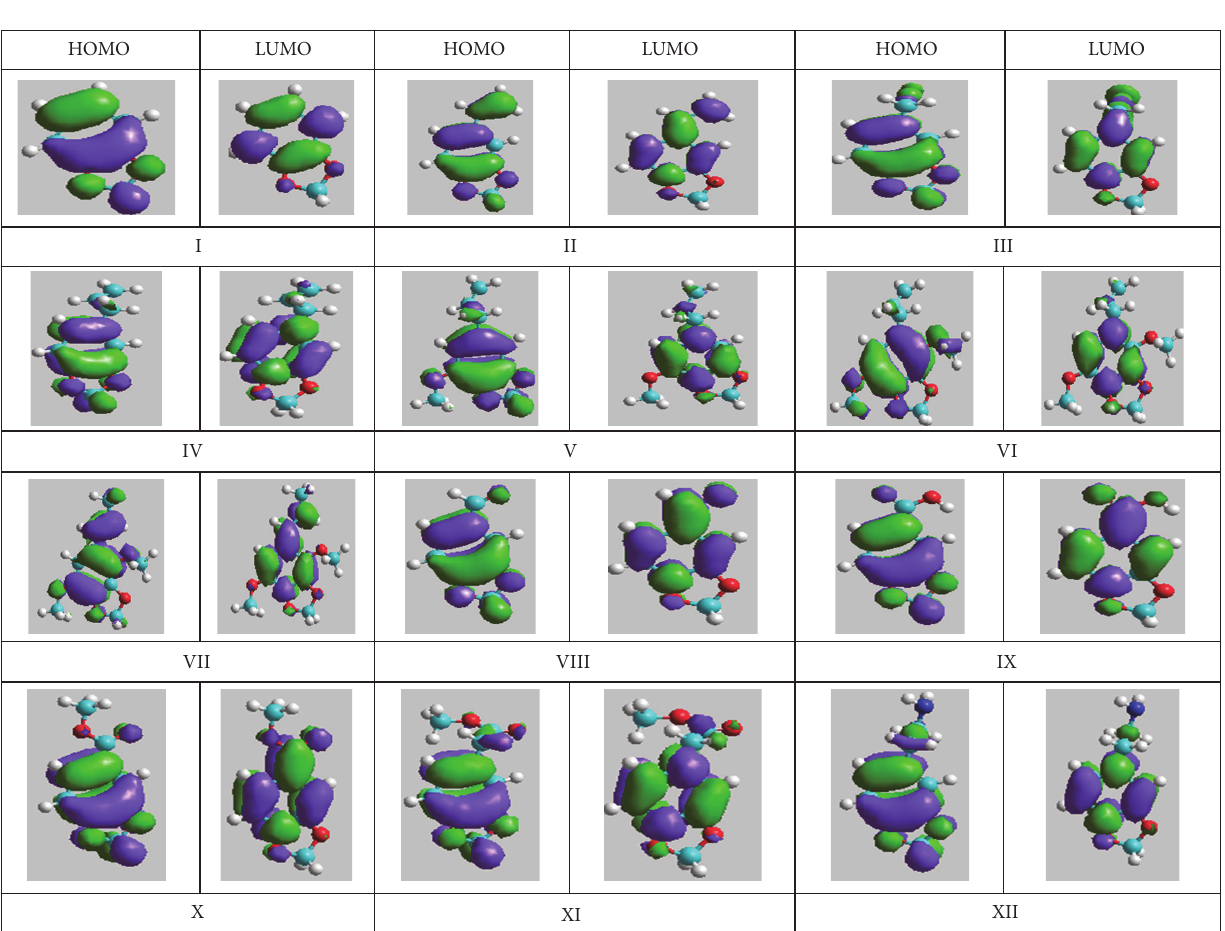
Figure 3: The HOMO and LUMO of the investigated 1,3-benzodioxole